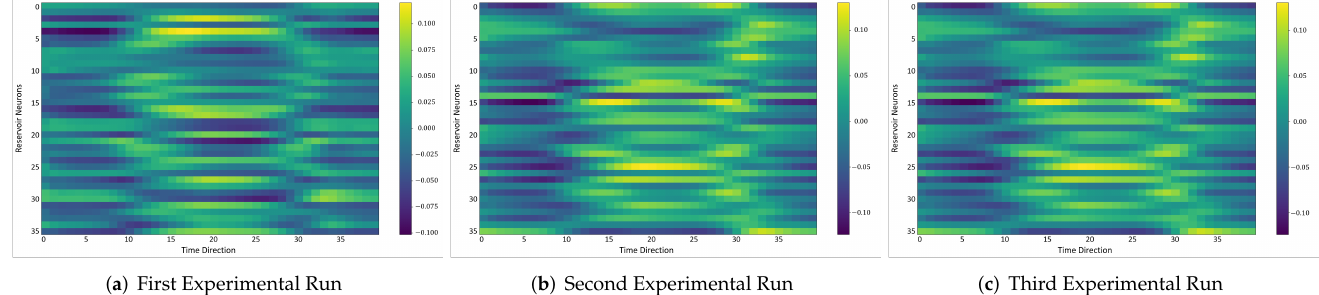
Figure 13. Visualization of ESRs of randomly initialized reservoir with 36 neurons for left arm trajectories of a person performing two-hand